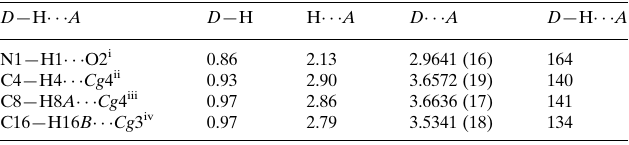
Hydrogen-bond geometry (A˚ , (cid:2) ). Cg 3 and Cg 4 are the centroids of rings C1–C6 and C9–C14,